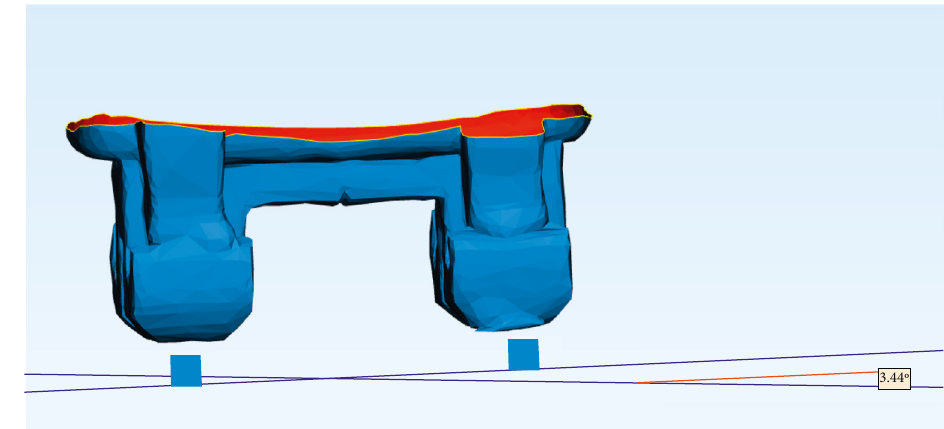
Figure 13: Rotational differences between the superimposed models. Table 1: Buccopalatal linear deviation ( Y -axis) for the orthodontic attachments.